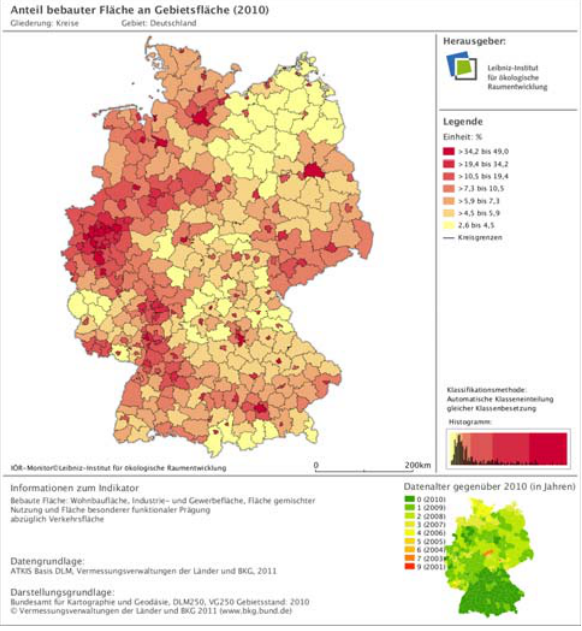
Figure 2. Viewer of the IOER-Monitor